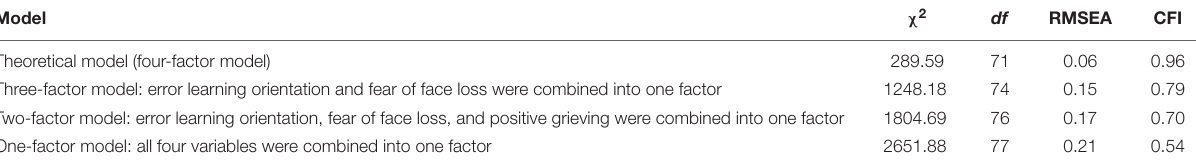
TABLE 1 | Comparison of measurement model.